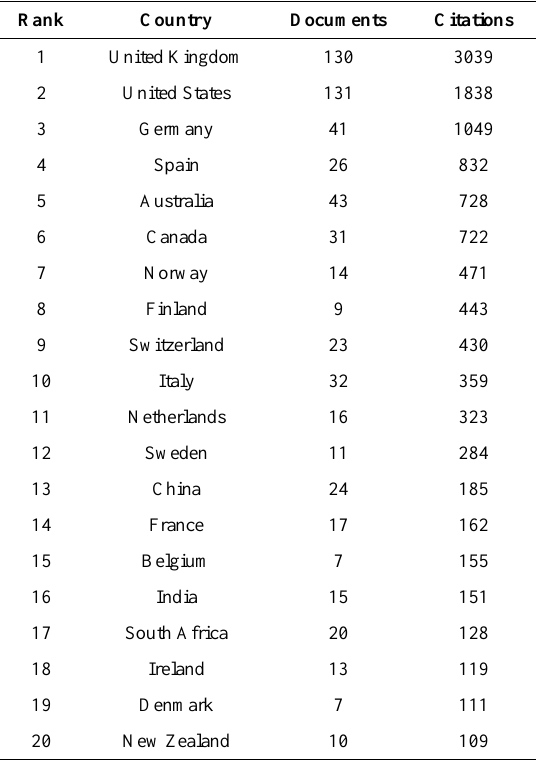
Table 3. Country-wise published reputation risk